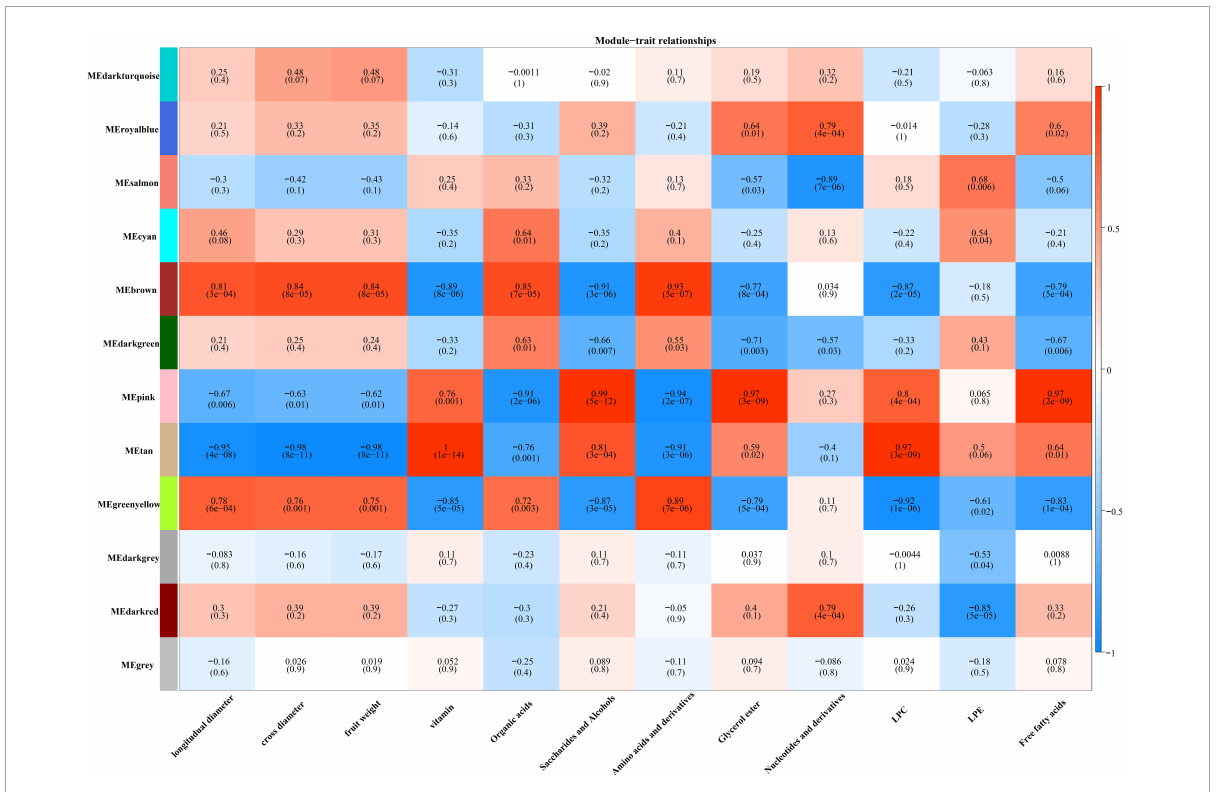
FIGURE5 Module-trait correlations. The color scale represents r 2 -values from –1 (blue) to 1